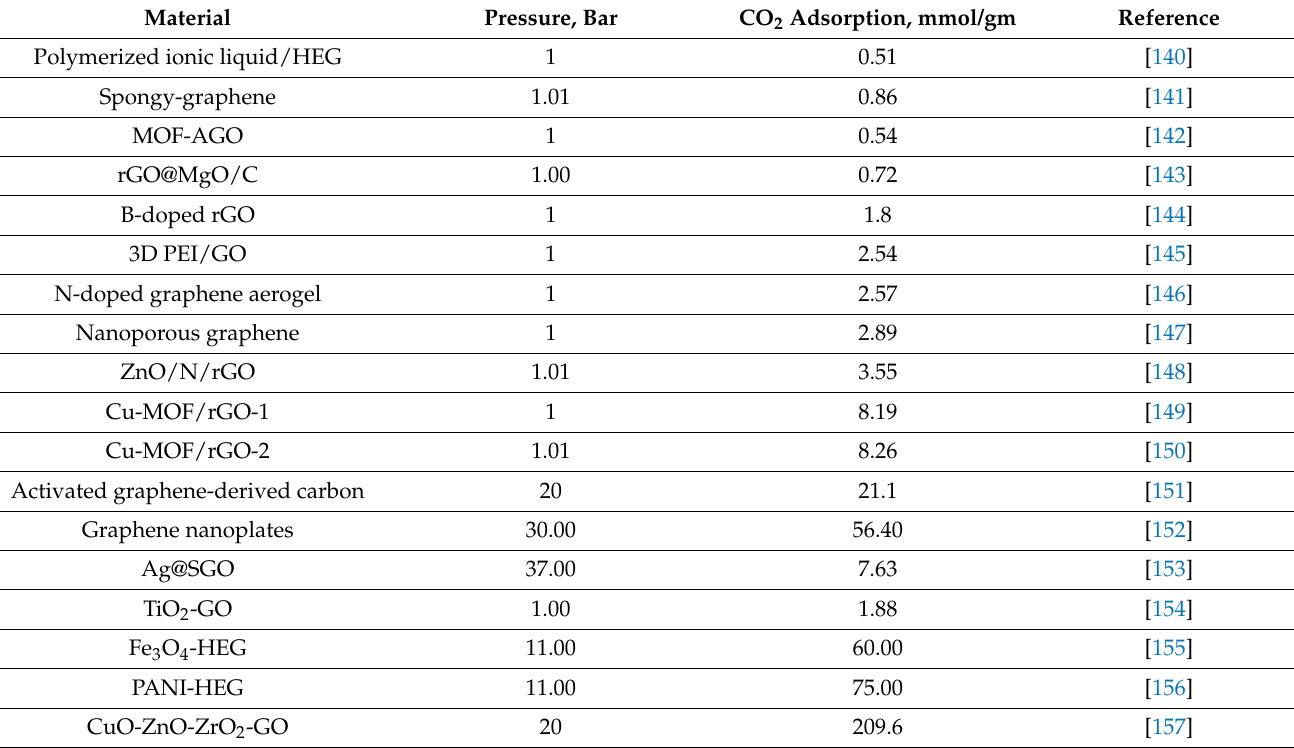
Table 3. List of Graphene Oxide–Metal Hybrids used in CO 2 Adsorption.